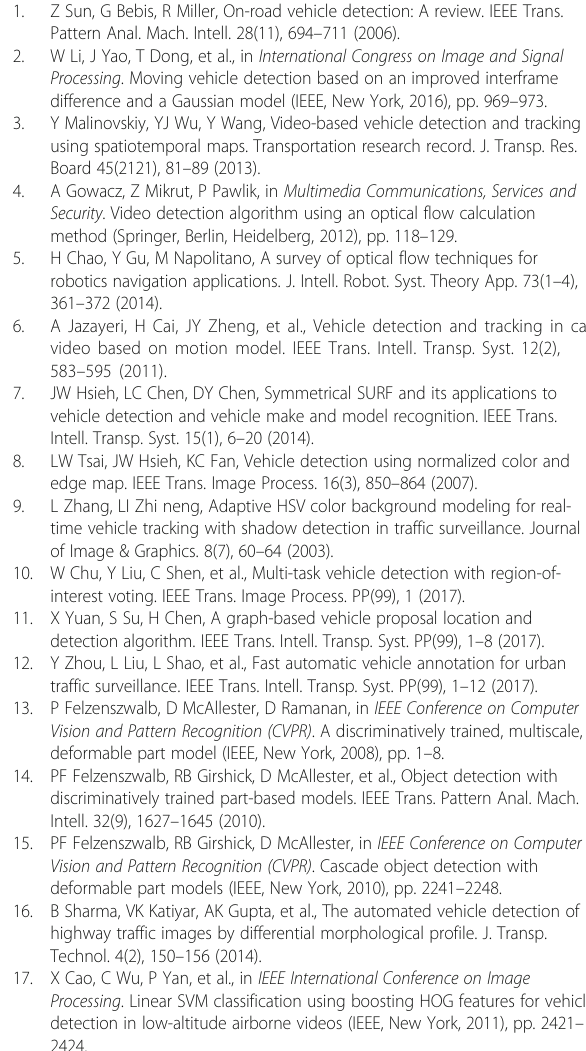
Fig. 6 Comparison of different vehicle target detection algorithms. DR vehicle detection rate, FPR vehicle false positive